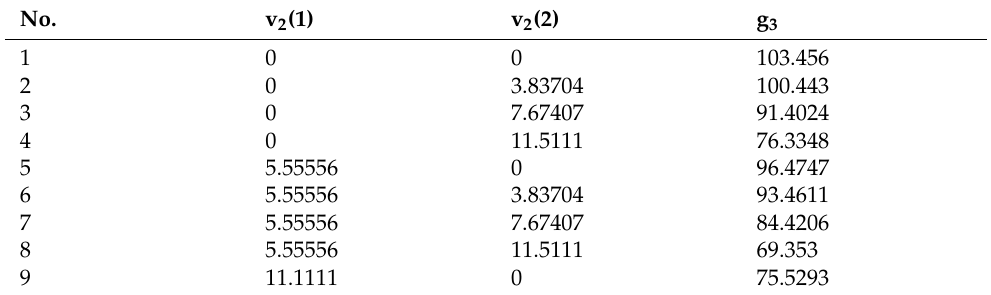
Table 2. Strategies of the second influence agent under fixed strategies of the Principal and the